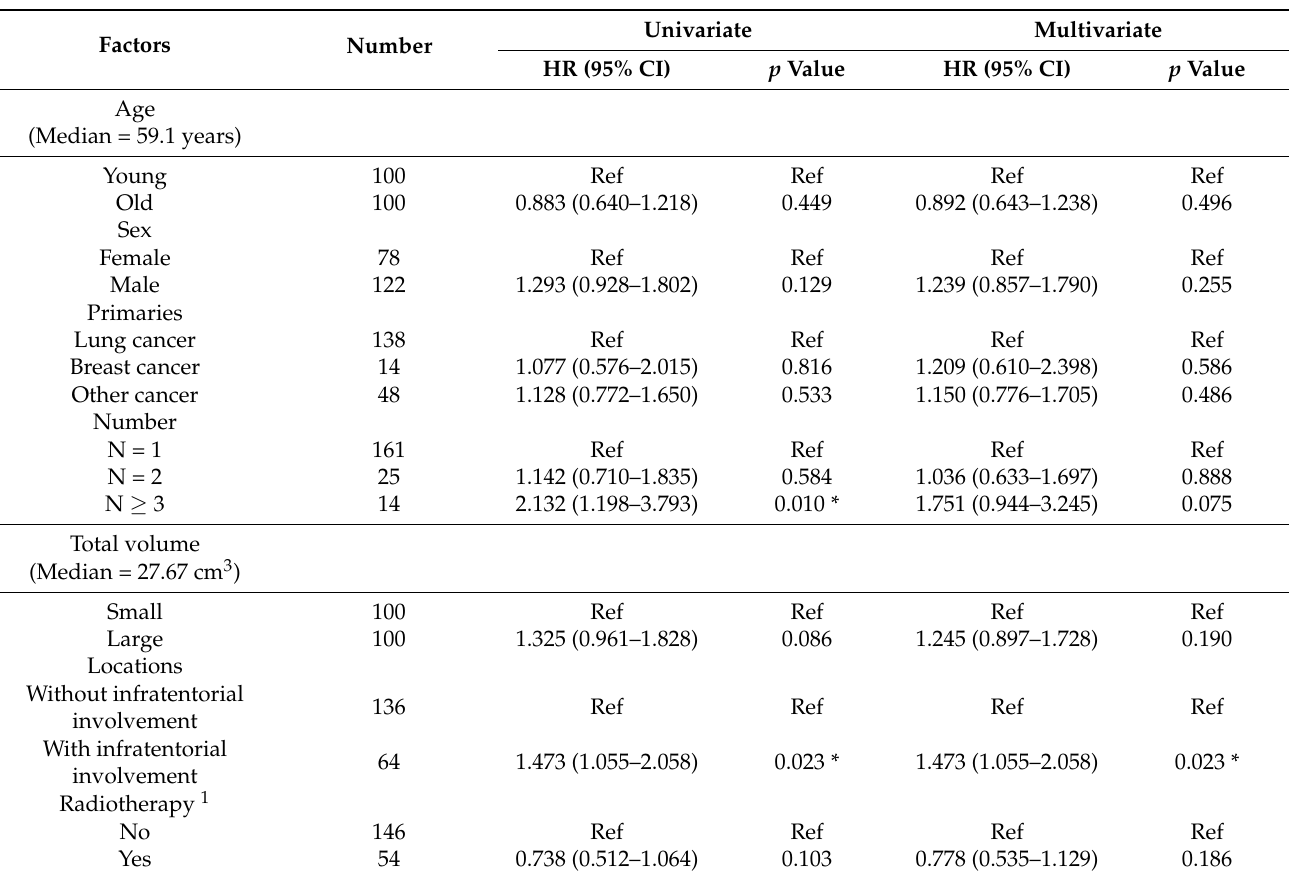
Table 2. Cox proportional hazards regression for brain metastases patients who received